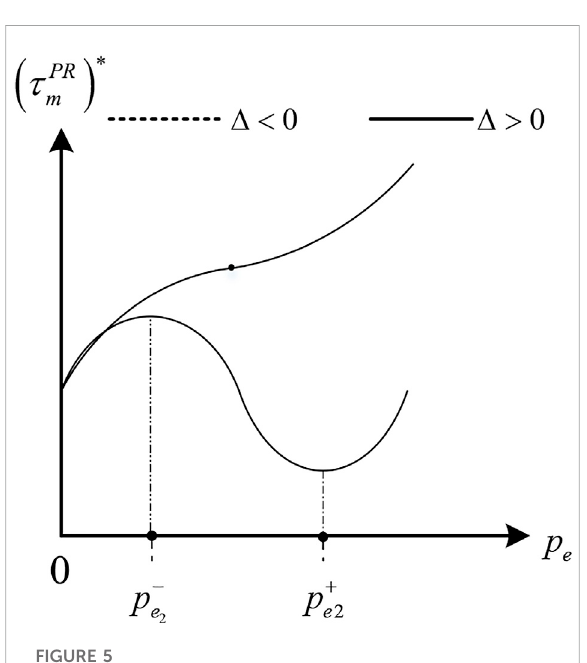
FIGURE 5 Emissions reduction level under strategy